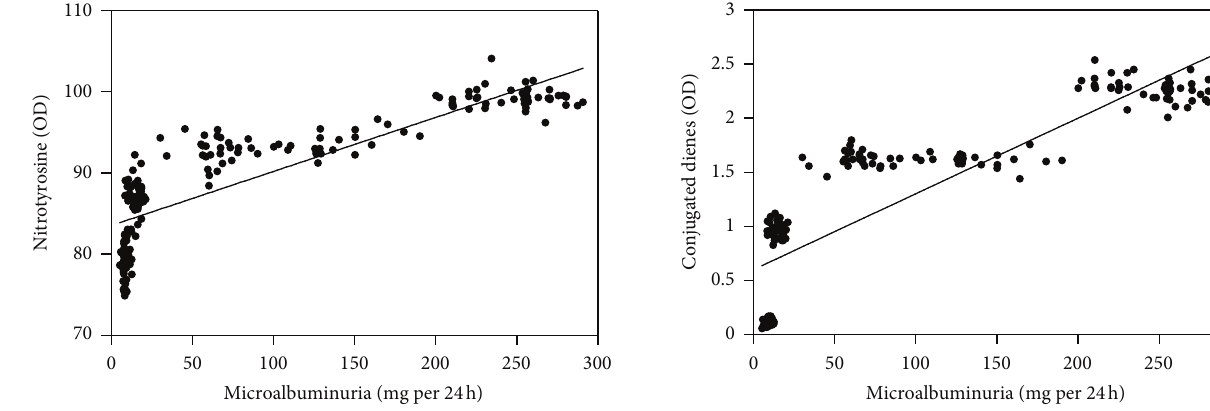
F 2: Correlation between microalbuminuria levels and conju- gated